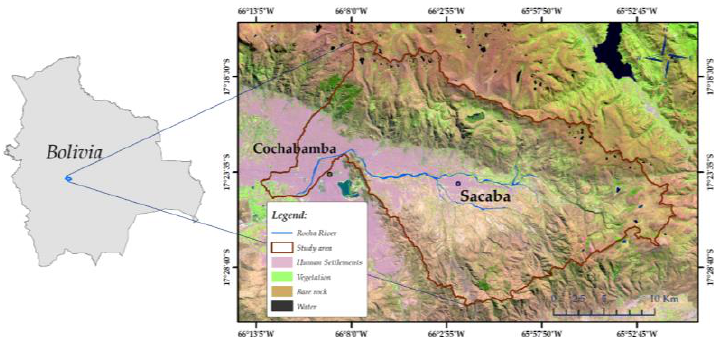
Figure 1. ( Left ) Study area location in Bolivia and ( right ) main cities and catchment boundaries shown on a Landsat 8 OLI (Operational Land Imager) and TIRS (Thermal Infrared Sensor) image (6, 4 and 2 combination in RBG) from June 19, 2017. The main channel of the Rocha River, which is an important tributary of the Caine River, runs east to west for approximately 80 km. The climate is semi-arid (low precipita- tion and high potential evaporation) according to data recorded at Aeropuerto-Cocha- bamba meteorological station (17°24′58′′ S, 66°10′28′′ W, altitude 2548 m) by the Bolivian Service of Meteorology and Hydrology. Median annual temperature in the period 1988– 2018 was 17.8 °C and median annual rainfall was 421.2 mm. Rainfall is concentrated in summer (on average 78% of yearly precipitation), during the months December to March, and mostly occurs in short-duration, high-intensity events producing large amounts of runoff. The dry and transition season (May to July) receive 3% and 19% of total annual precipitation, respectively. In the catchment, mountains, hills, piedmonts and valleys make up the landscape. The altitude ranges between 2500 and 4500 m. In general, soil water permeability is mod- erately high, organic matter content is low and there is varying abundance of rock frag- ments in the soil. Soil erosion occurs as rill, pipe and gully erosion. In the piedmont area,